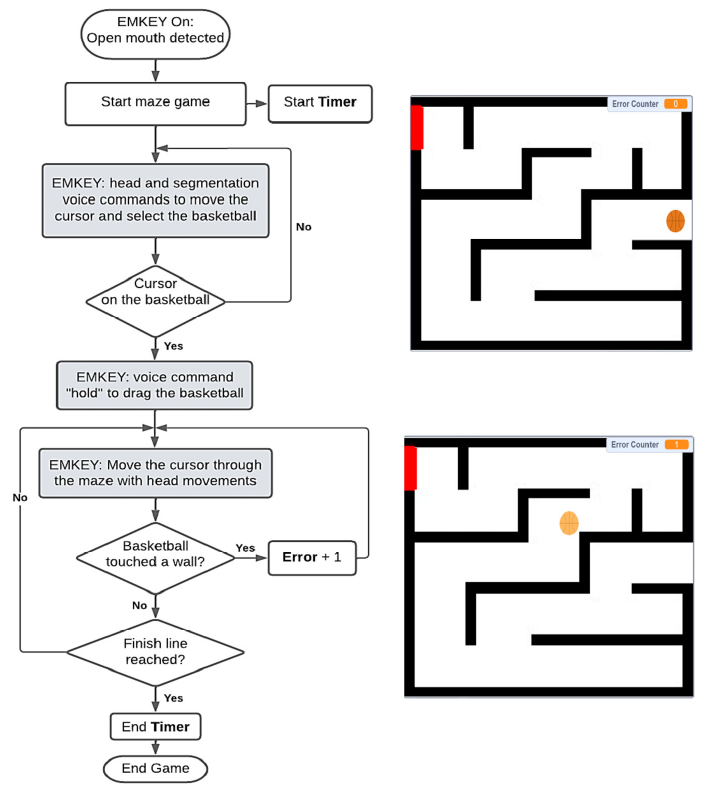
Figure 4. Maze game flowchart and interface. Finish line is the red rectangle in the maze.